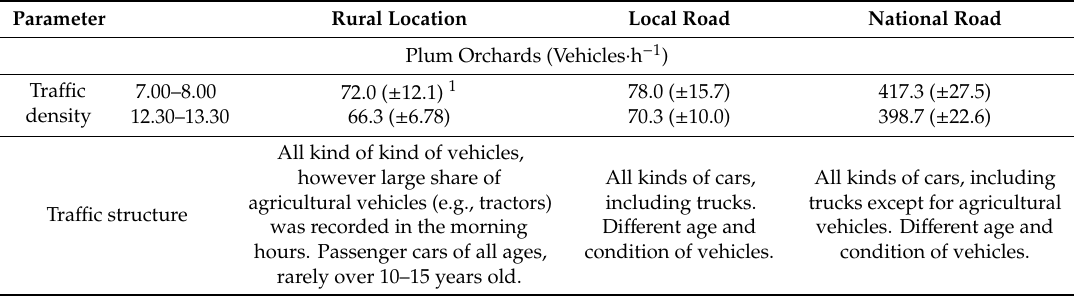
Table 4. Tra ffi c intensity and structure on the roads closest to the plum orchards. Data are means ± SE, n = 3.